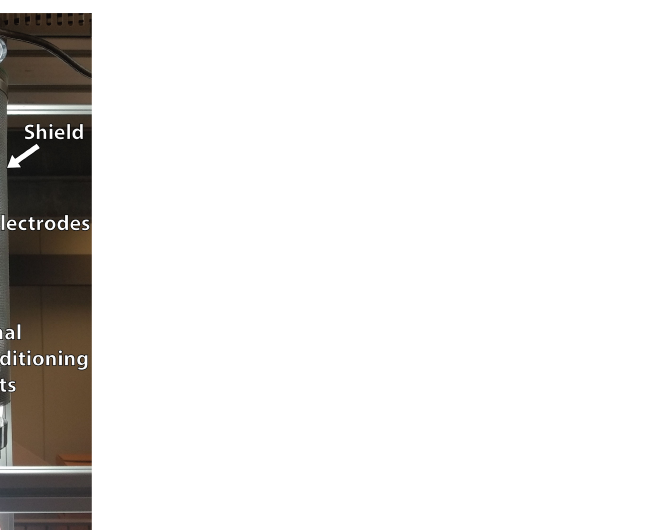
Figure 10. Electrical resistance tomography sensor installed in the pipe of the inline swirl separator. The electrodes and signal conditioning units can be seen inside the shield, used to isolate the measurement region from external electromagnetic